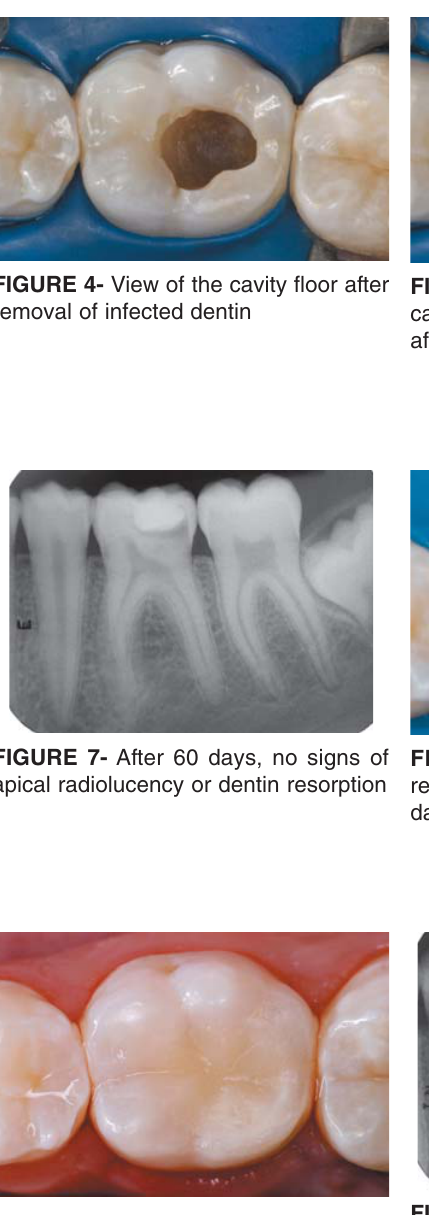
FIGURE 10- Occlusal view of the final restoration with